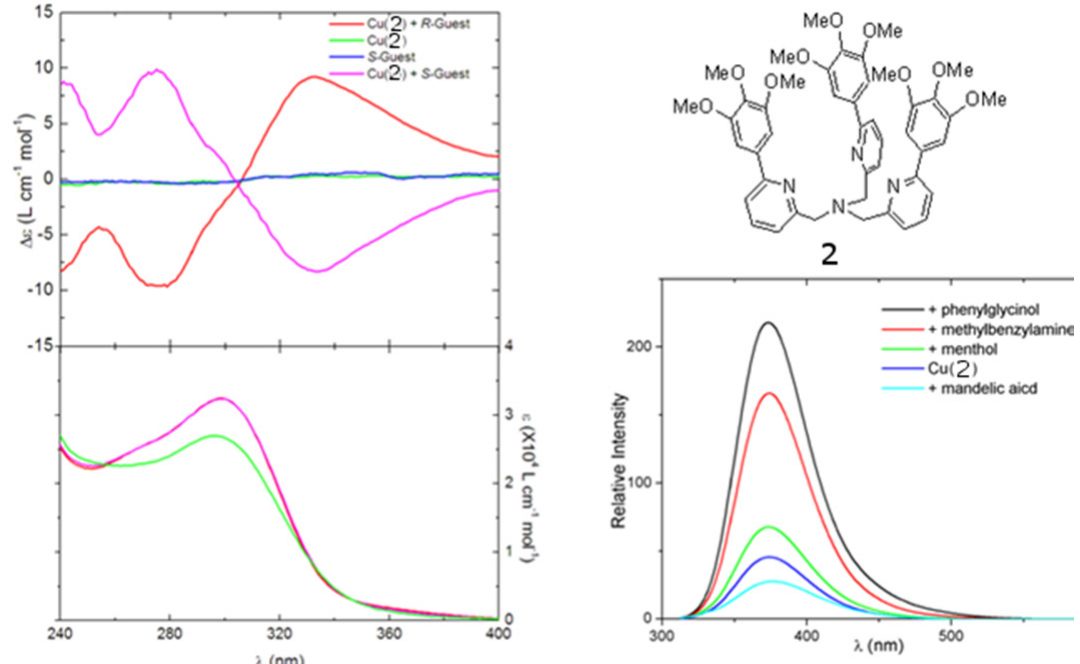
Figure 3. ( A ) Circular dichroism (top) and UV (bottom) spectra of [Cu( 2 )] 2+ complexed with chiral guests 2-phenylglycinol. ( B ) Fluorescence modulation of [Cu( 2 )] 2+ by selected small molecule guests [26]. Reproduced by permission from the author of reference